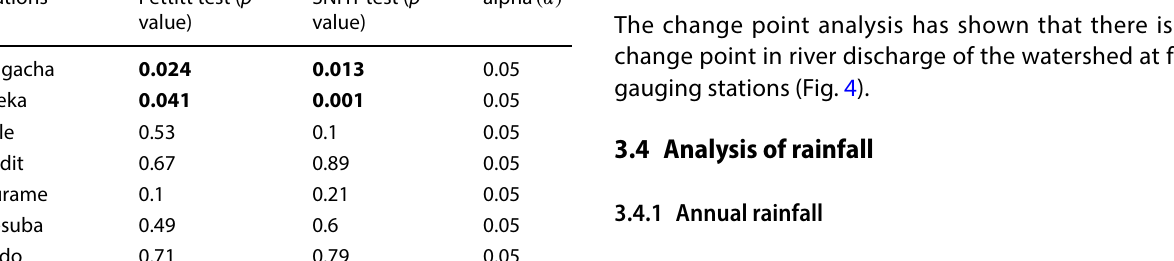
Table 2 The p values obtained from the homogeneity tests for the annual rainfall Stations Pettitt test ( p −